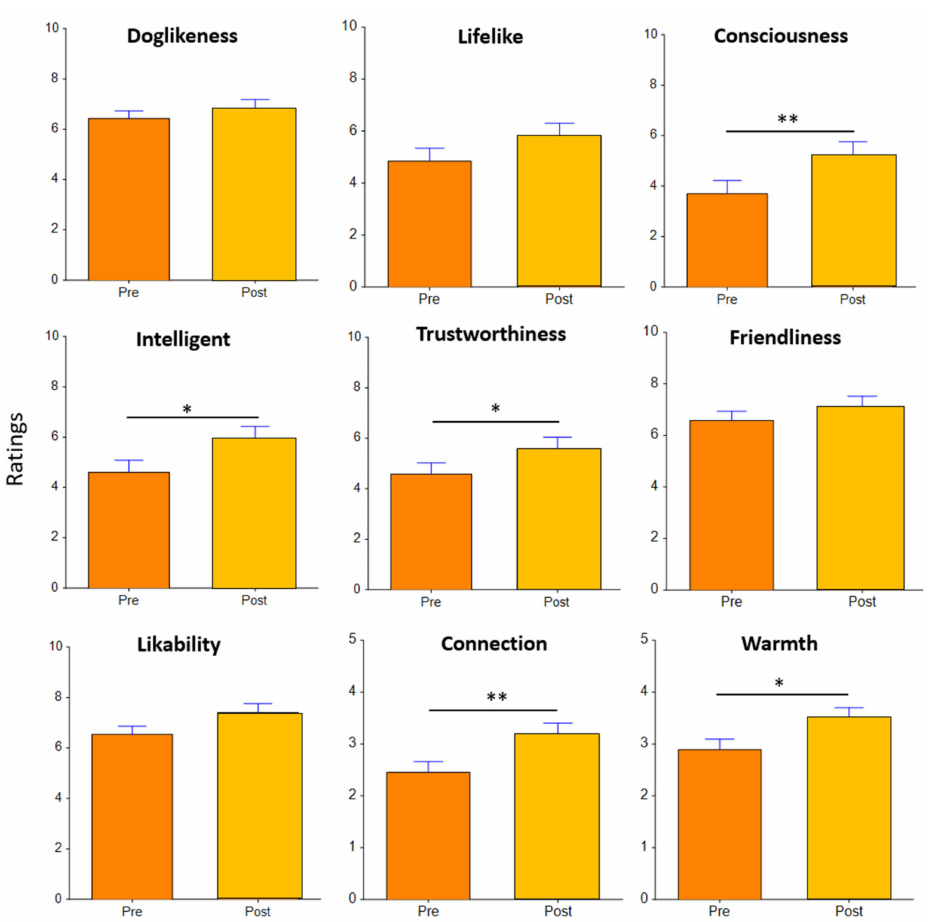
Figure 8. Self-reported ratings of “positive” perceived characteristics of the robot pre-interaction (in orange) and post interaction (in yellow). * p < 0.05, ** p <